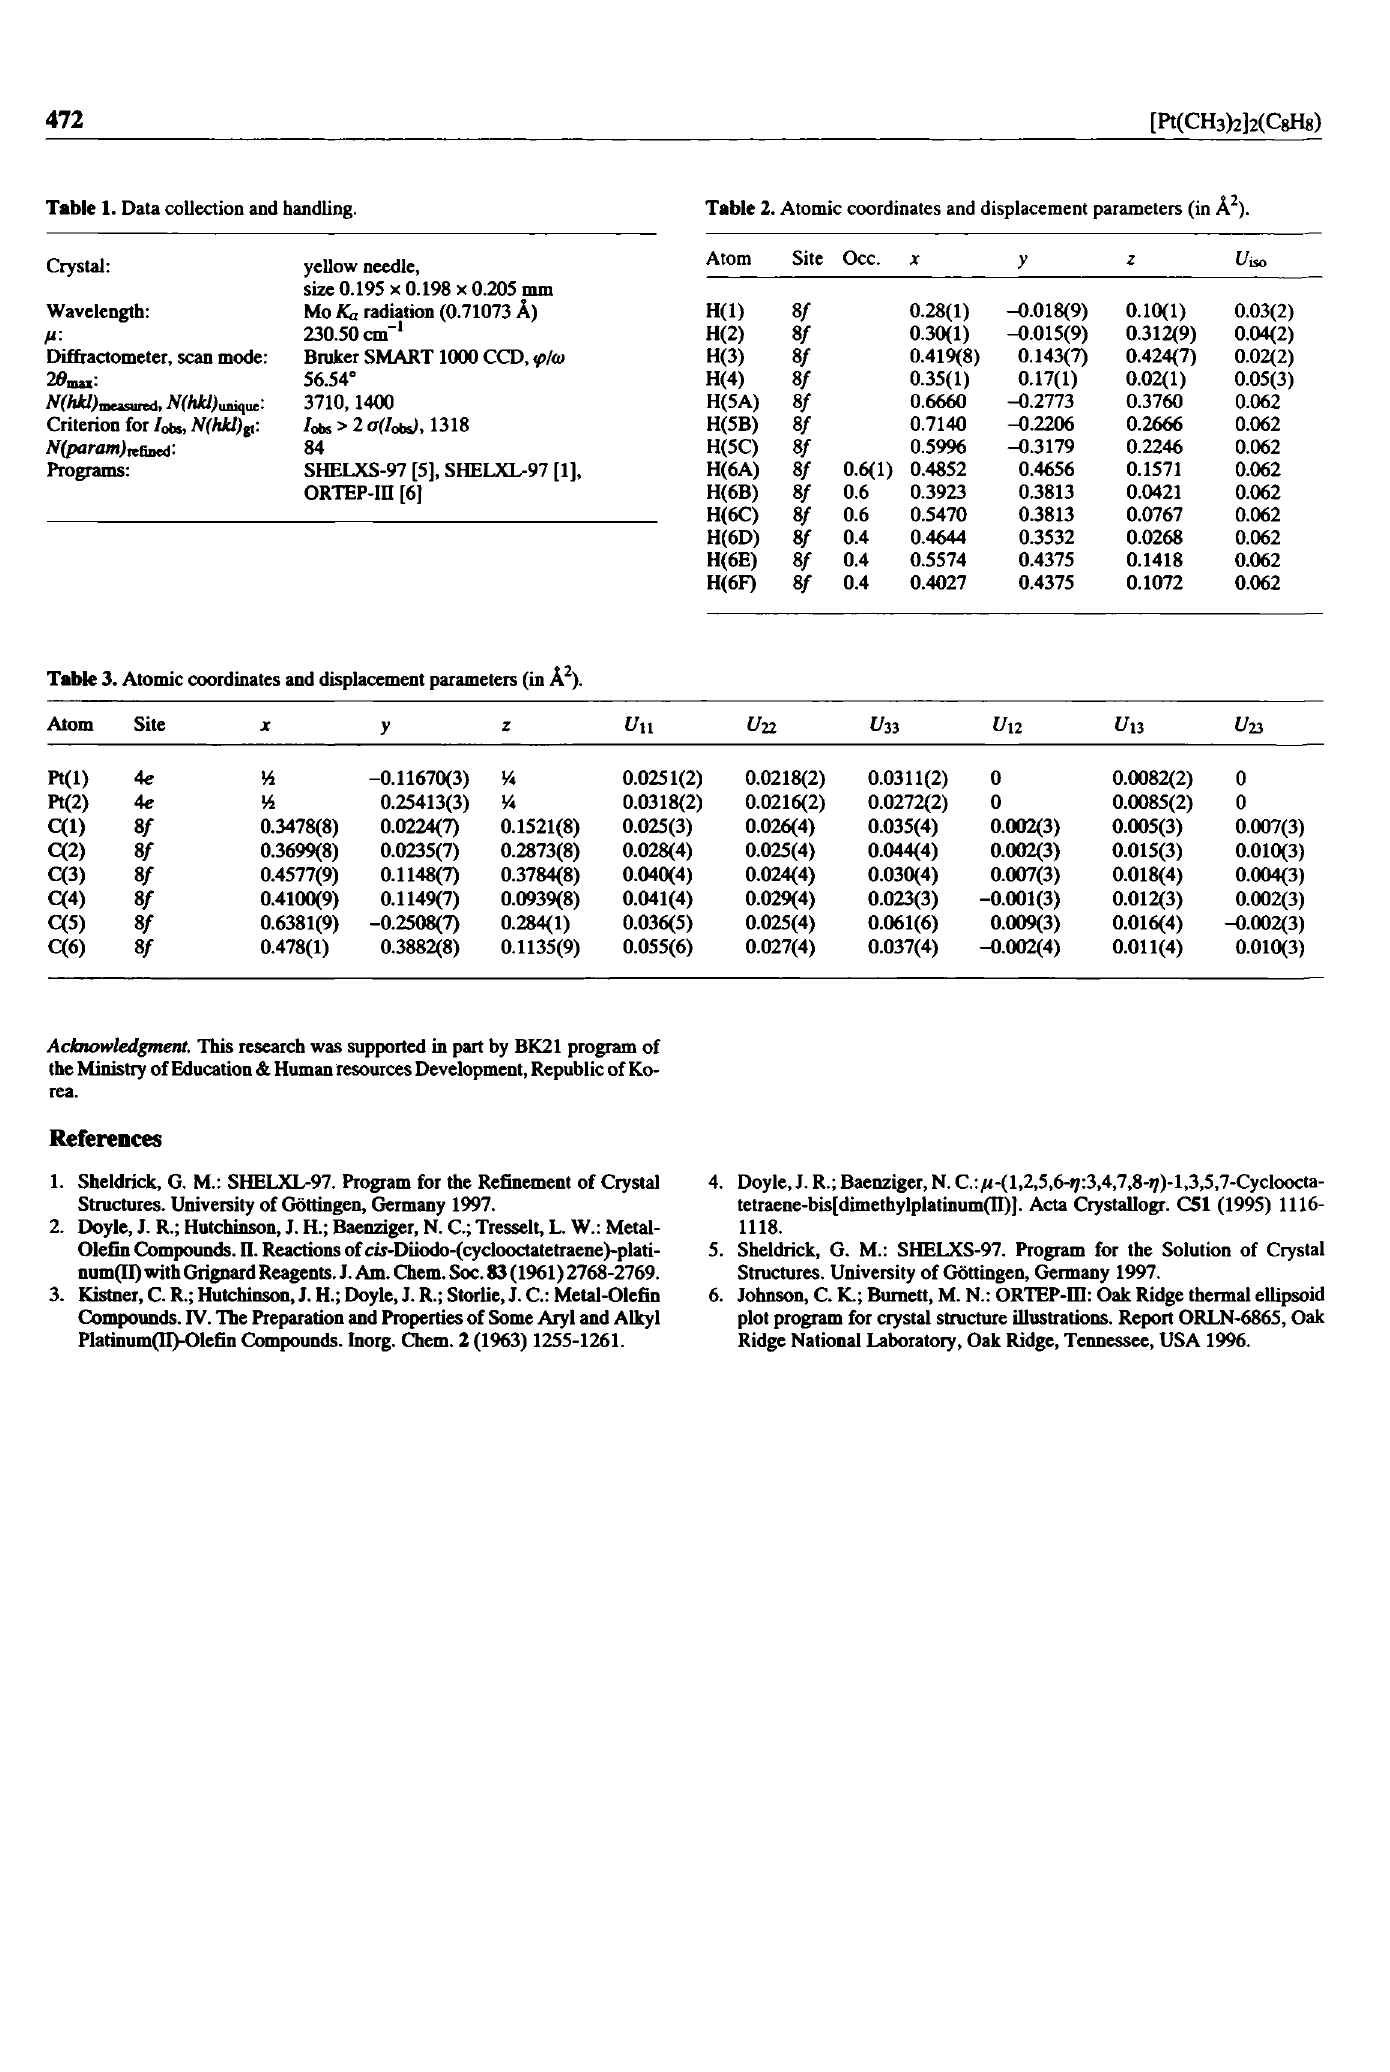
Table 3. Atomic coordinates and displacement parameters (in Ä 2